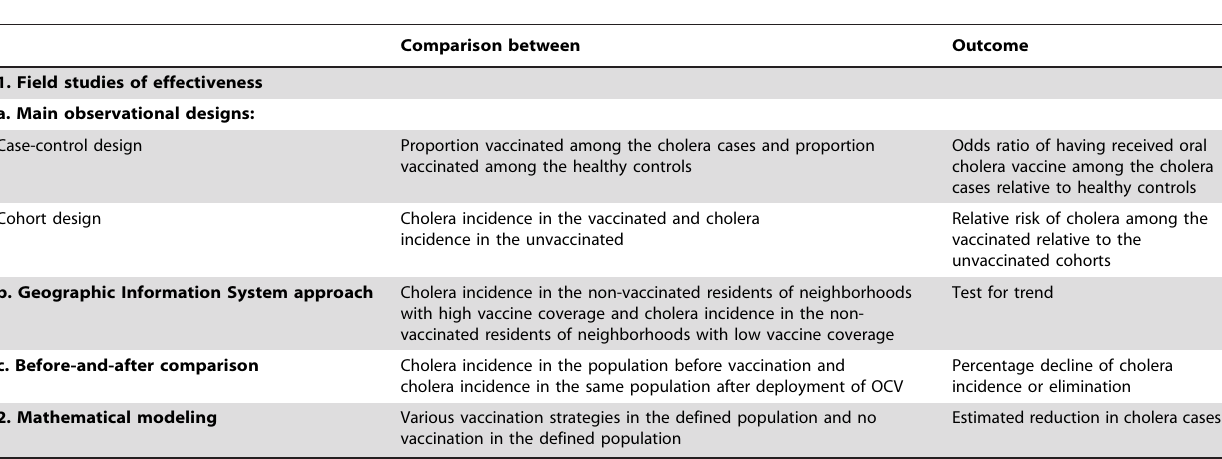
Table 1. Methods to assess the impact of mass oral cholera vaccination